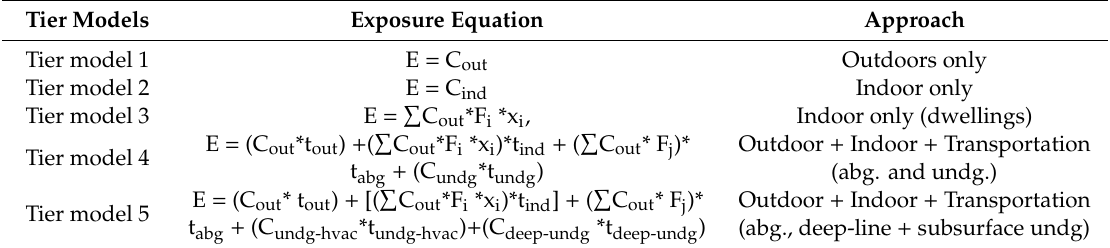
Table 1. Tier models for assessing the time-weighted